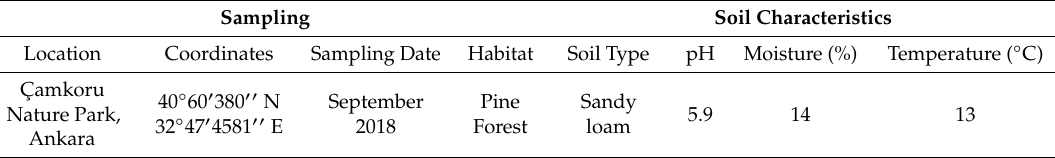
Table 1. Locality, habitat, sampling date, and soil characteristics of the positive